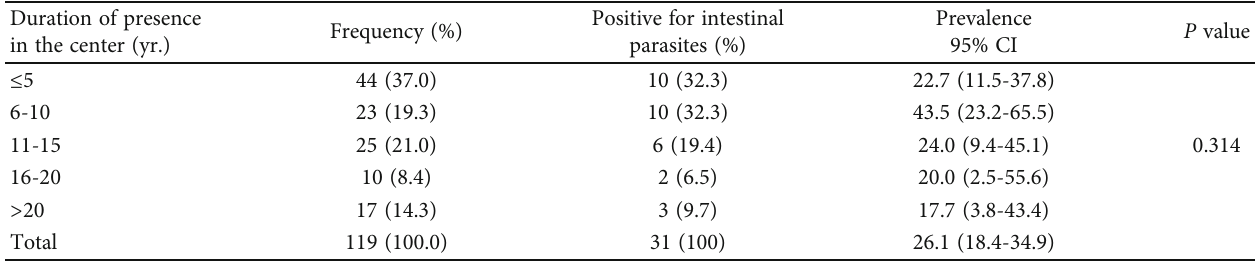
Table 4: Frequency of parasitic infections, based on the duration of stay in the care center, among intellectually disabled individuals in Bandar Abbas County, Southern Iran. in the center (yr.)